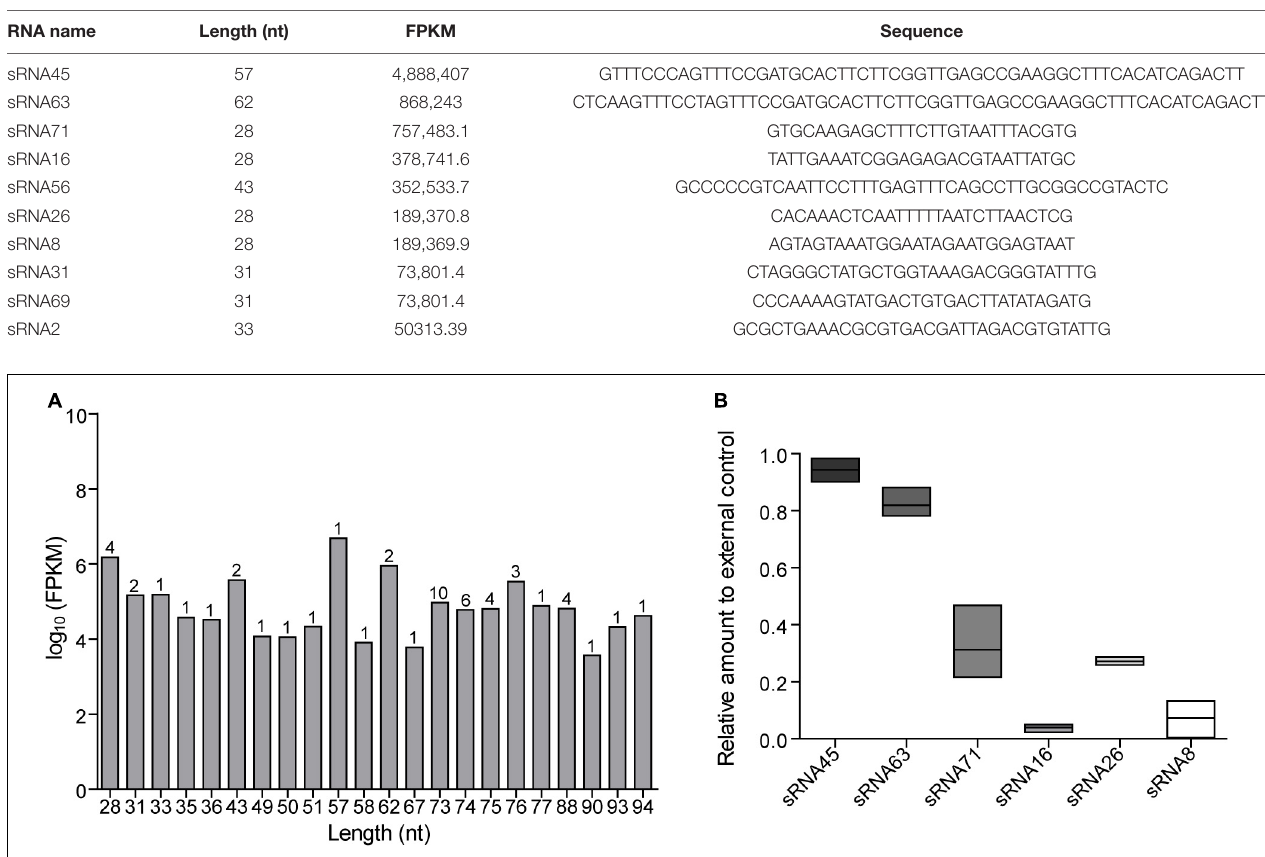
TABLE 1 | Top 10 most prevalent sRNA reads of LDEVs.